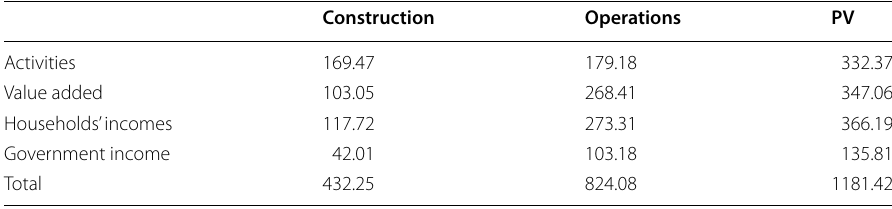
Table 5 Total project impact